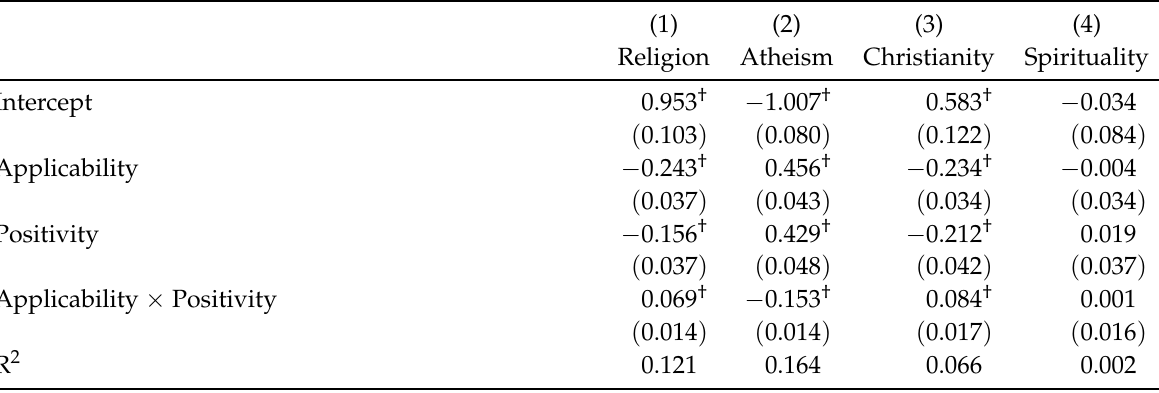
Table 3: Atheists: OLS regression estimates of difference of natural log of response time to natural log of average response